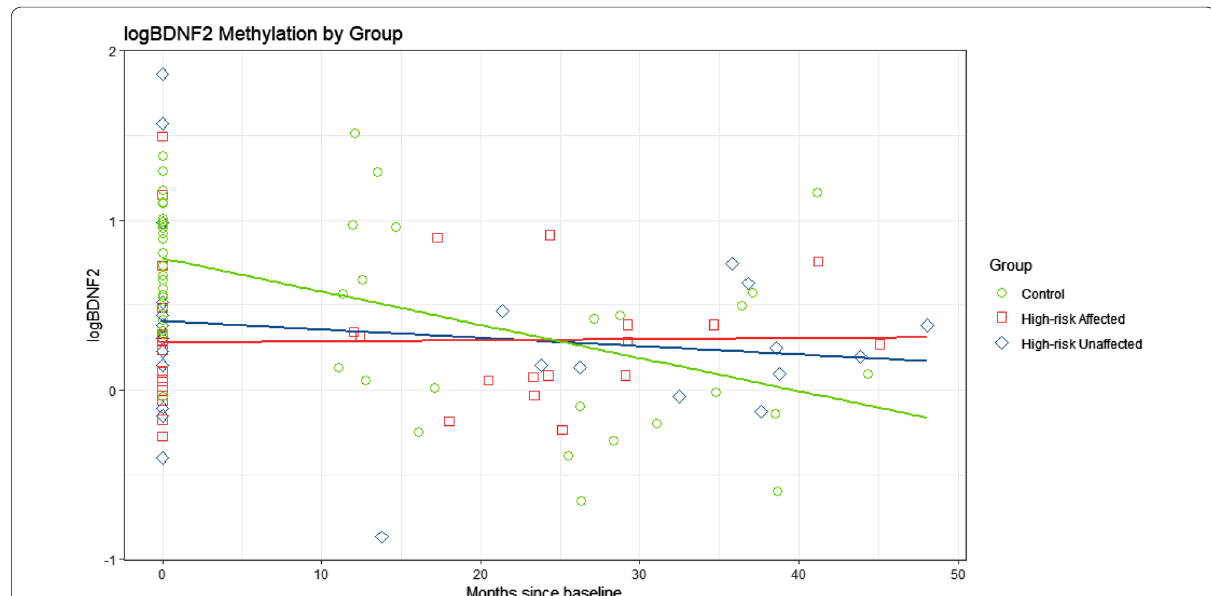
Fig. 4 Log BDNF‑2 methylation percentage by study group from the longitudinal model between Time 1 and Time 2. Estimated longitudinal profiles of log BDNF‑2 methylation rates. After adjustment, there was evidence that the rate of decrease in controls (green) is steeper than the rate of decrease of affected HR (red) (p 0.0140, t‑value 2.55), and marginally steeper than in unaffected HR (blue) (p = = − There was no evidence that the change over time of affected HR (red) was different from unaffected HR (blue) (p